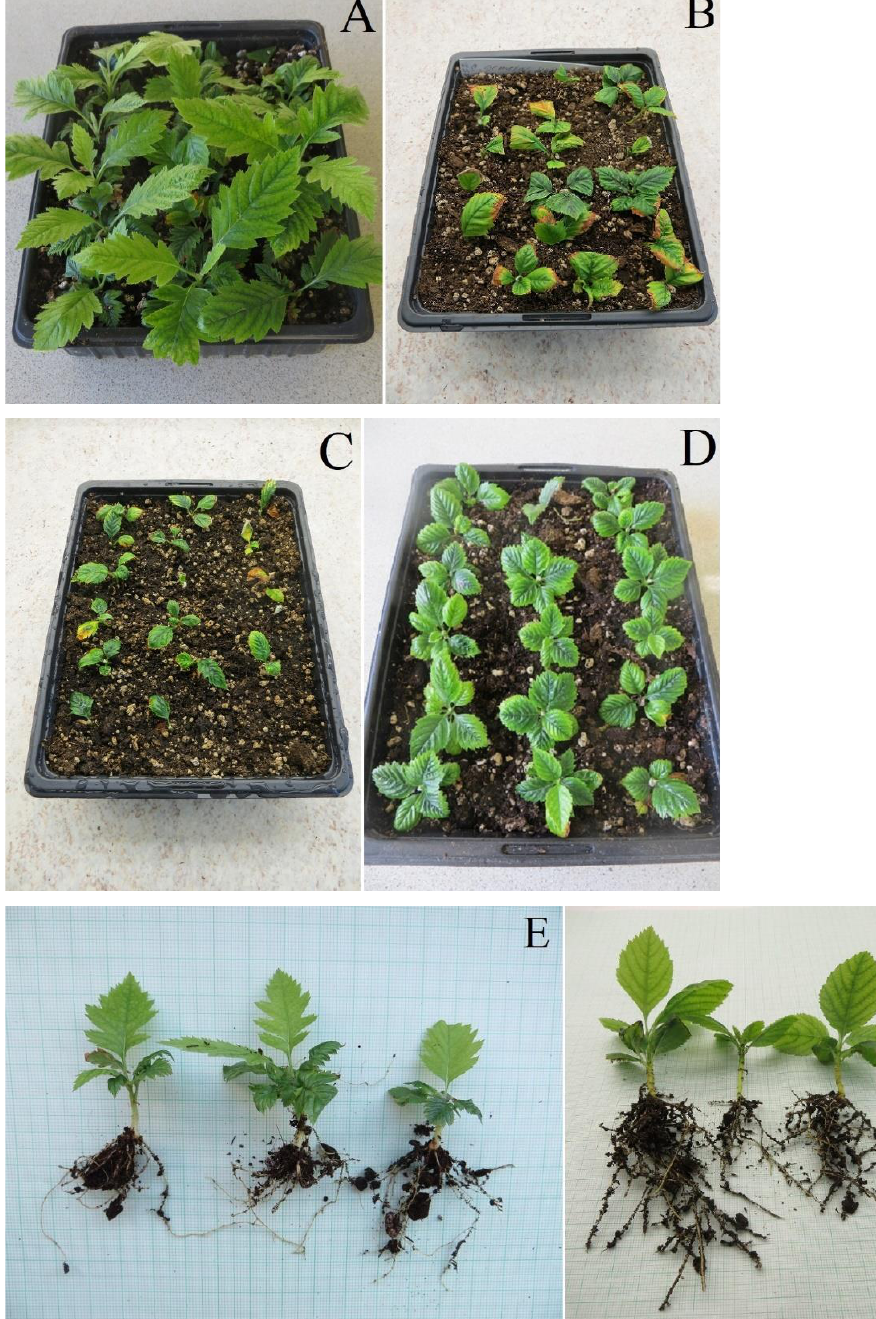
Figure 3. Comparison of the development of microcuttings in Sorbus species in the best rooting treatment in a steamed peat-perlite substrate after six weeks. ( A ) Sorbus × abscondita , microcuttings treated with 2% indole-3-butyric acid (IBA) rooting powder. ( B ) Sorbus gemella , the control. ( C ) Sorbus × kitaibeliana , the control. ( D ) Sorbus omissa , the control. ( E ) Detail of rooted plantlets of Sorbus × abscondita . ( F ) Detail of rooted plantlets of Sorbus omissa . Root production also depended on the presence and the concentration of IBA in the rooting powder (Figure 2C). Auxin treatments (1% and 2% IBA) reduced the rooting percentage significantly (40% and 32%) compared to the control (61%). On the other hand, the auxin significantly increased the mean number of roots per microcutting, both in the